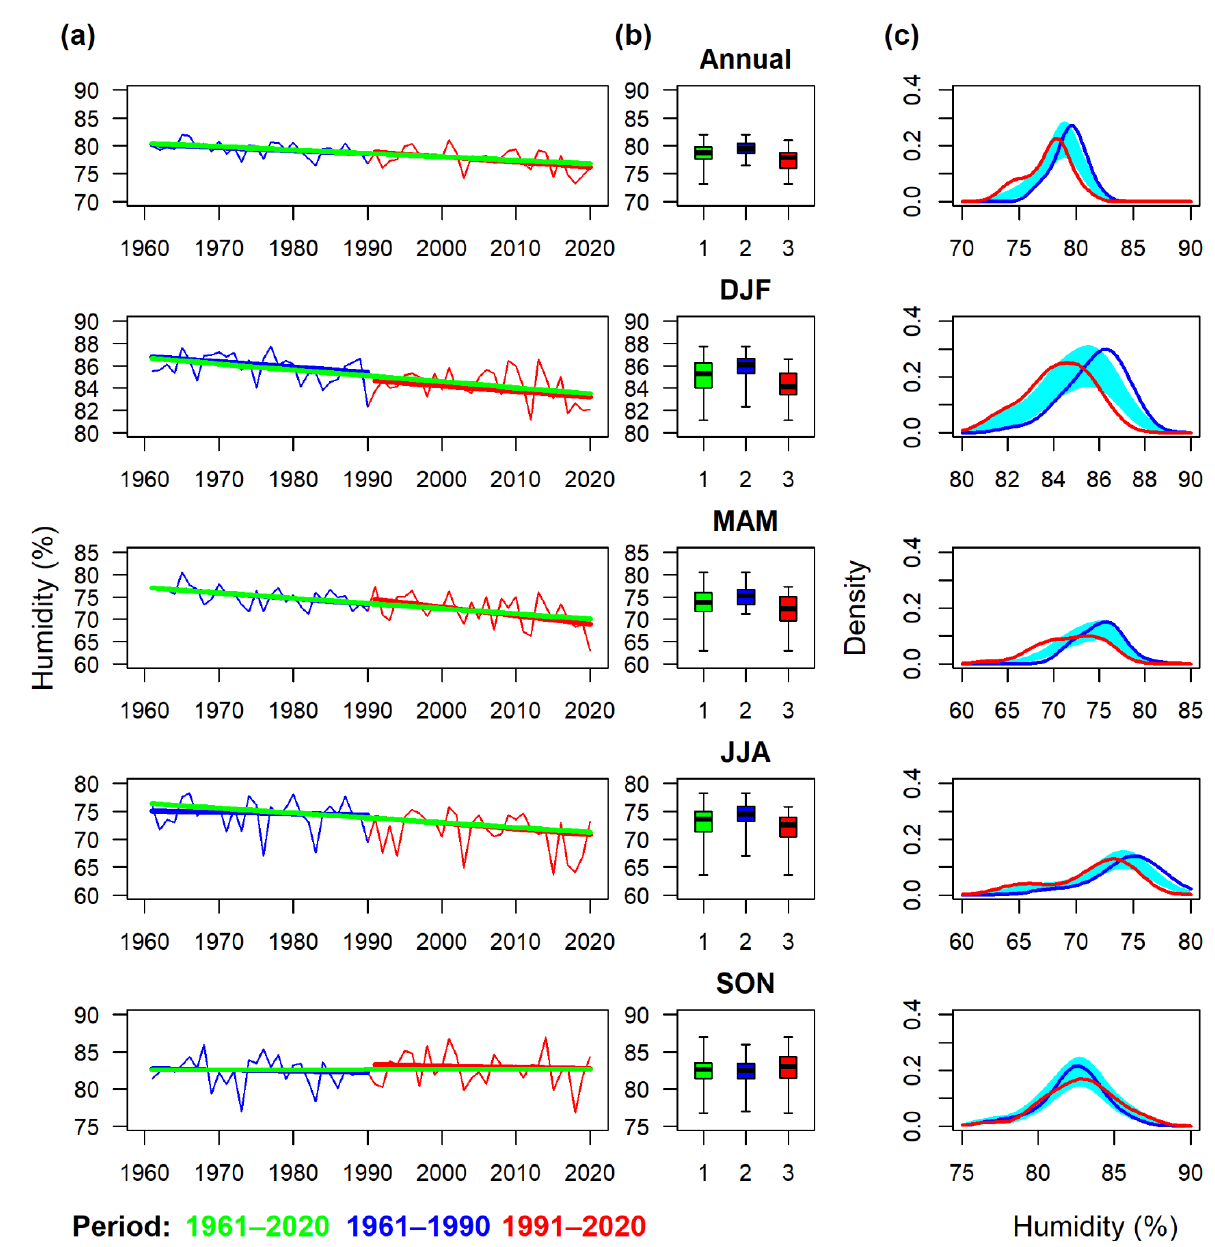
Figure 9. Annual and seasonal mean relative humidity series for the territory of the Czech Republic in the 1961 – 2020 period: ( a ) fluctuations with linear trends in the entire period, 1961 – 1990 and 1991 – 2020; ( b ) box plots (median, lower and upper quartile, minimum, and maximum) for 1961 – 2020 (1), 1961 – 1990 (2), and 1991 – 2020 (3); ( c ) the density distribution of the series in 1961 – 1990 and 1991 – 2020. The density curves outside the reference band (green – blue) indicate a significant difference in the two distributions (and vice versa).